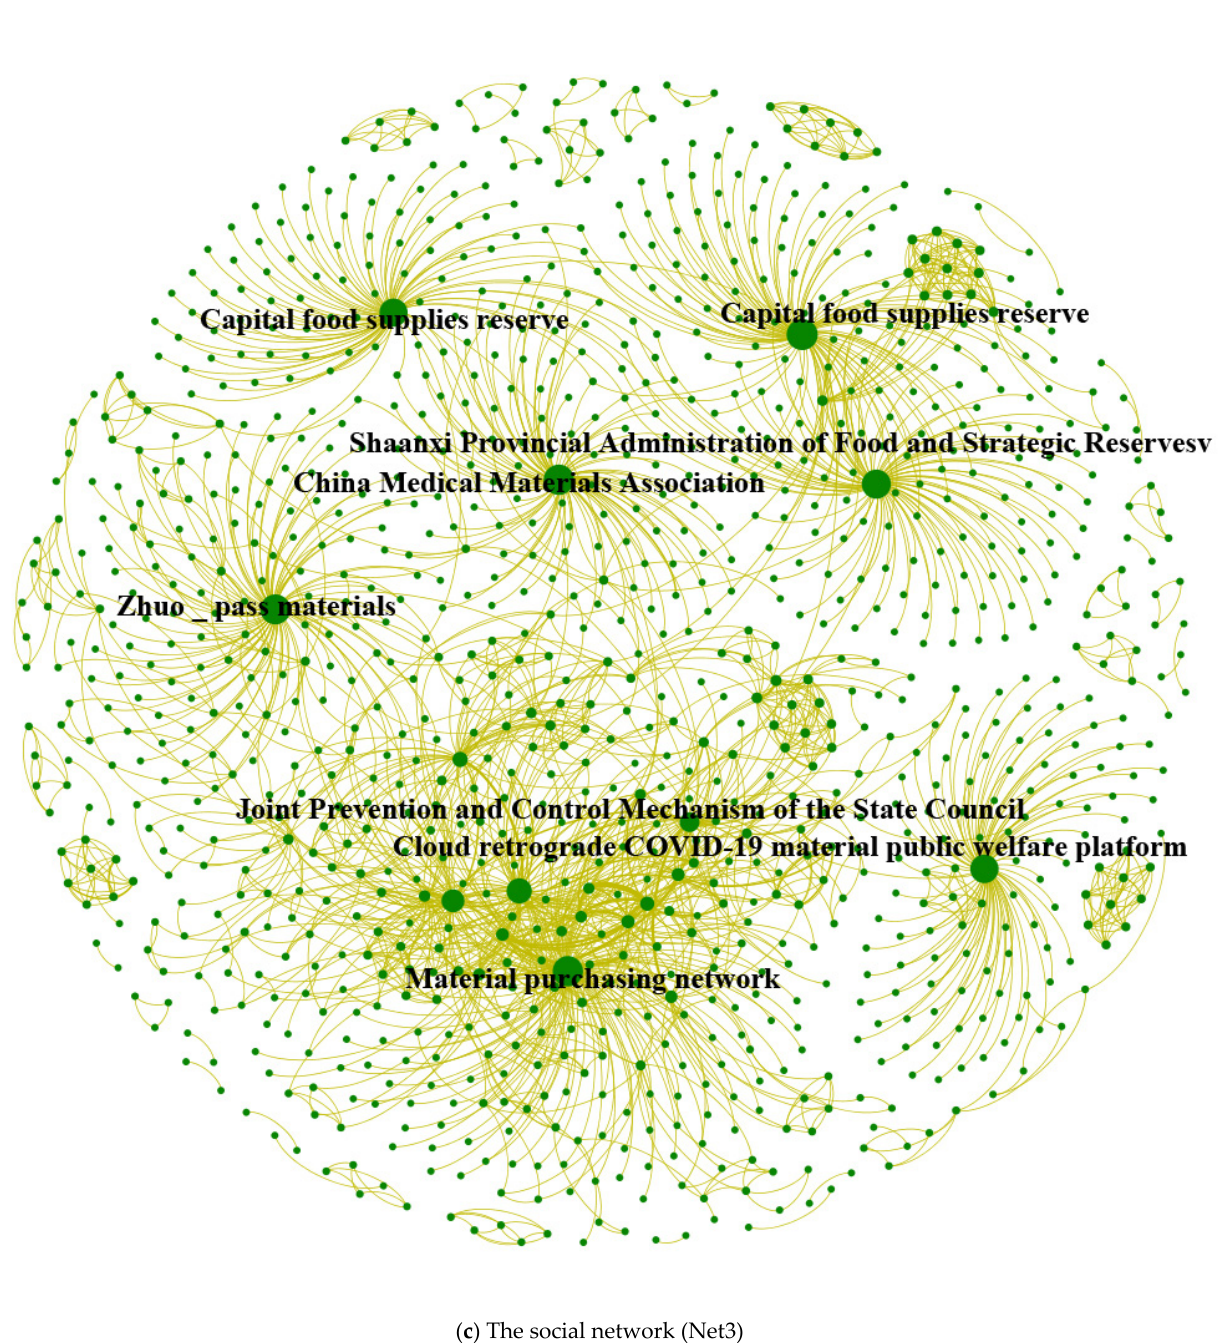
Figure 3. Cooperative Networks of Supply Support Organizations.